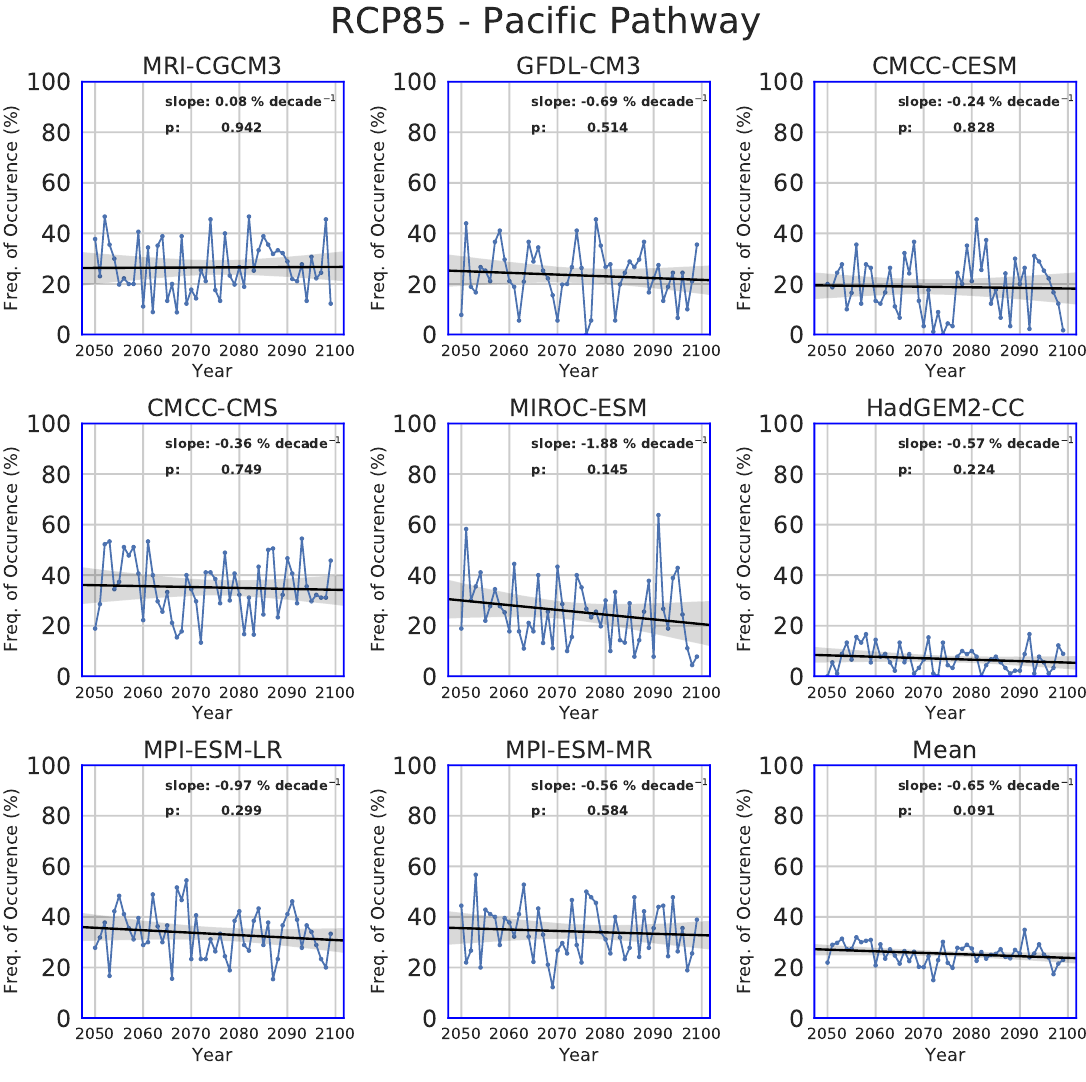
Figure 13. Same as in Figure11, but for the Pacific